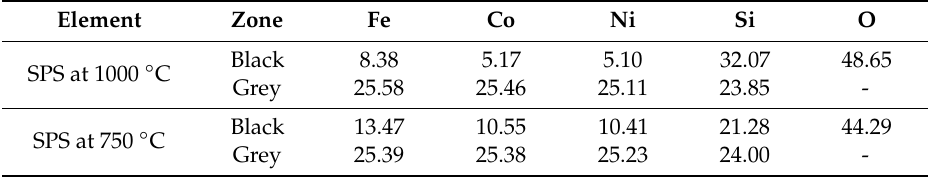
Figure 7. Piston displacement as a function of the temperature during the sintering of the powders. Table 4. Chemical composition (in at. %) of the specimens given by energy-dispersive X-ray spectra